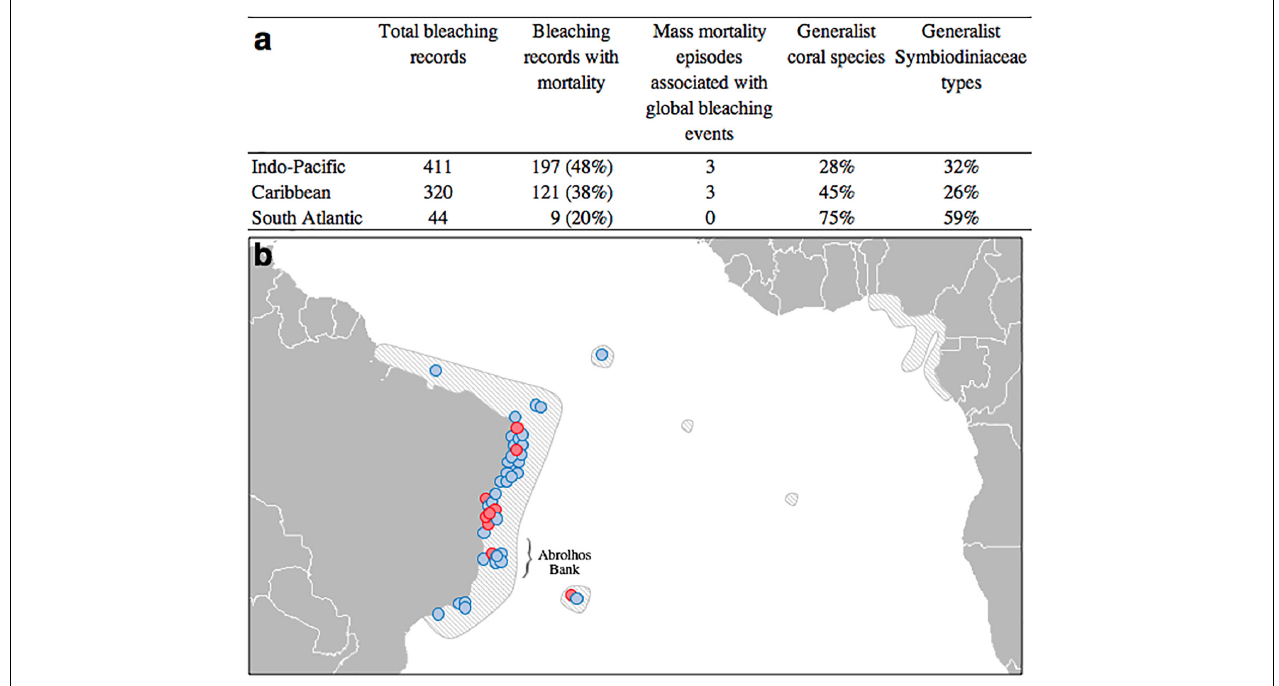
FIGURE 3 | Severity of bleaching episodes in Indo-Pacific, Caribbean and South Atlantic reefs: (a) Bleaching-associated mortality records, proportion of generalist reef-building coral species and proportion of generalist symbiont phylotypes in Indo-Pacific, Caribbean and South Atlantic coral reefs. (b) Geographical distribution of all documented South Atlantic coral bleaching episodes as of 2018. Red and blue circles indicate records with and without mortality, respectively. Distribution of coral reefs and large coral communities is within the shaded areas. South Atlantic bleaching episodes references: 23, 103–148 in Supplementary Material Reference List S1